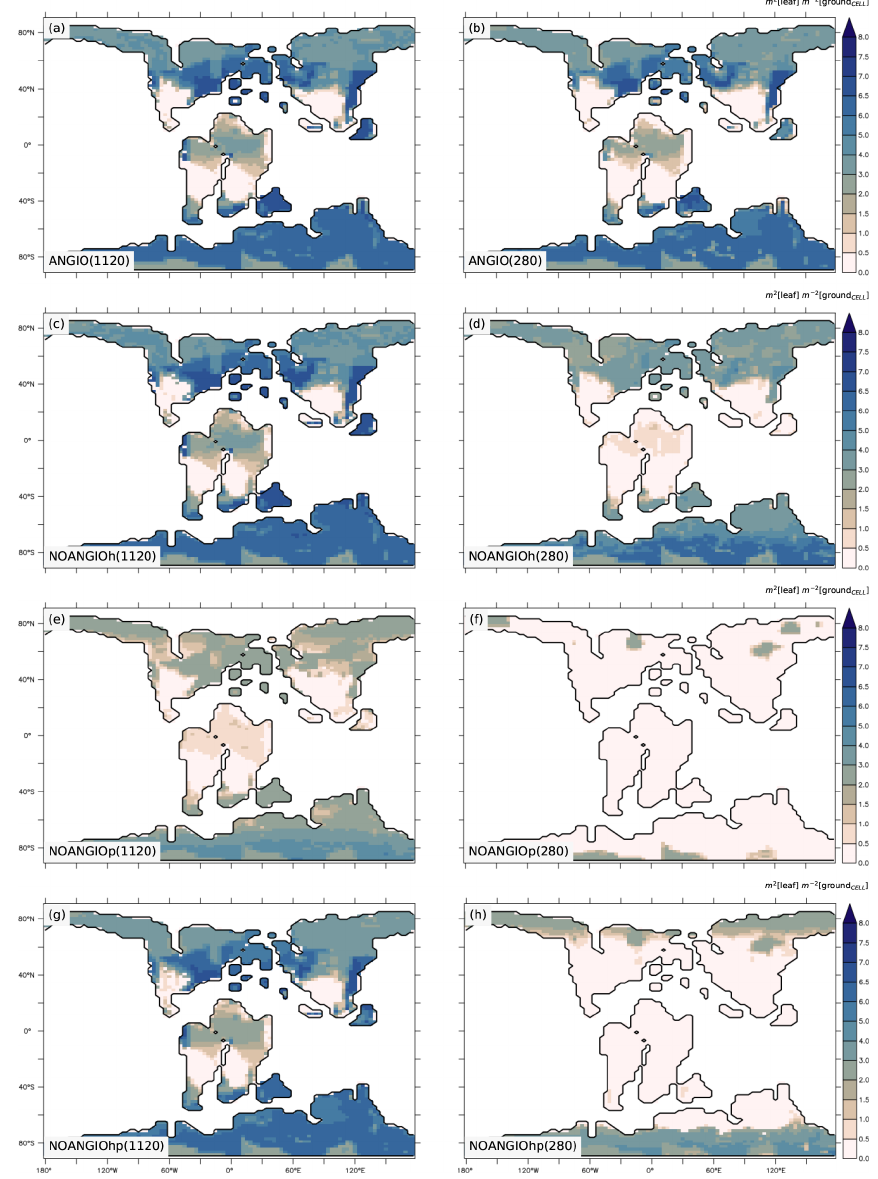
Figure 5. Annual mean LAI (m 2 [leaf]m − 2 [ground CELL ]) for (a) ANGIO(1120), (b) ANGIO(280), (c) NOANGIOh(1120), (d) NOAN- GIOh(280), (e) NOANGIOp(1120), (f) NOANGIOp(280), (g) NOANGIOhp(1120) and (h) NOANGIOhp(280). The annual mean LAI is the weighted average of leaf area index of each PFT per surface of ground of a grid cell (i.e., surface averaged across all PFTs including bare soil, written ground CELL in the